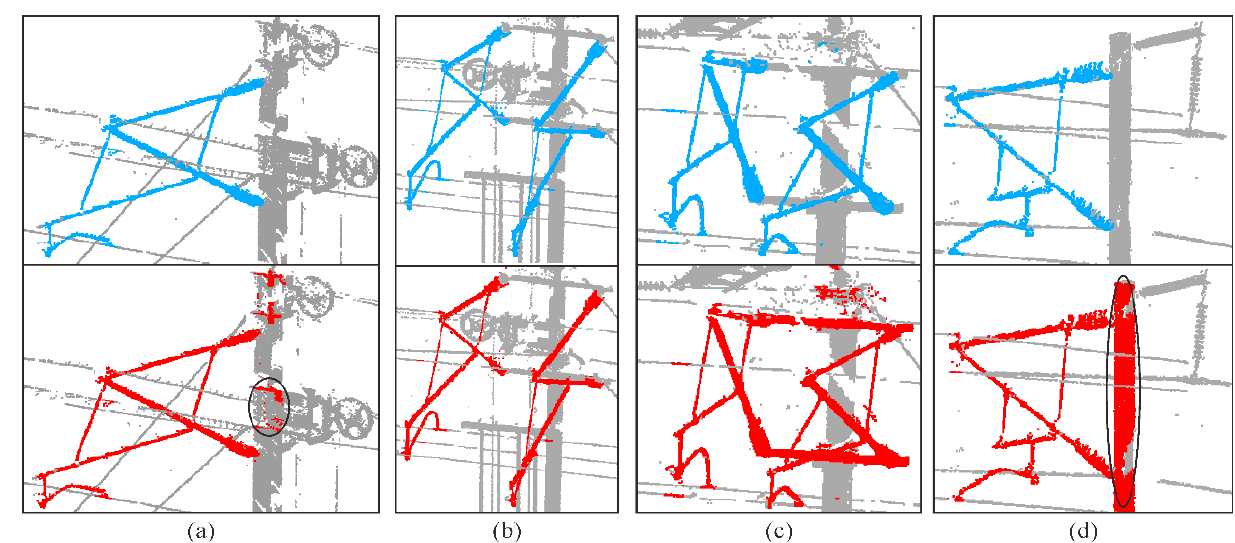
Figure 13. Differences in the extraction effects of the integrated PF, RC, and VPF filters and integrated RC and VPF filters. Specifically, the blue results are the extractions of the integrated PF, RC, and VPF, and the red results are the extractions of the integrated RC and VPF. ( a ) The application of the two filters on the SRSD. ( b ) The application of the two filters on the DRSD. ( c ) The application of the two filters on the SFSD. ( d ) The application of the two filters on the LSD.